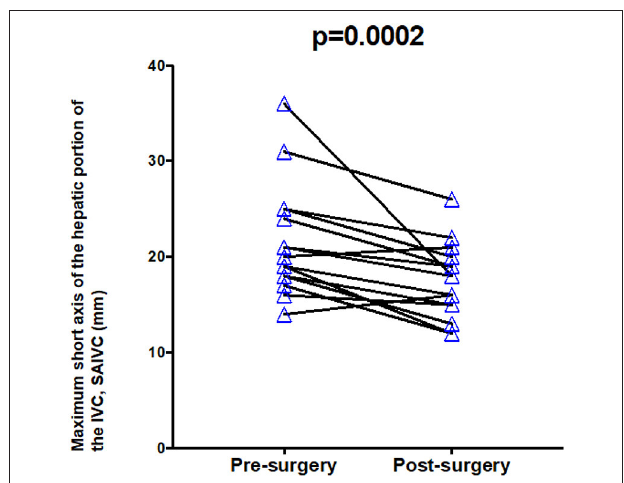
FIGURE 7 | Maximum short axis of hepatic IVC pre- and post-treatment.